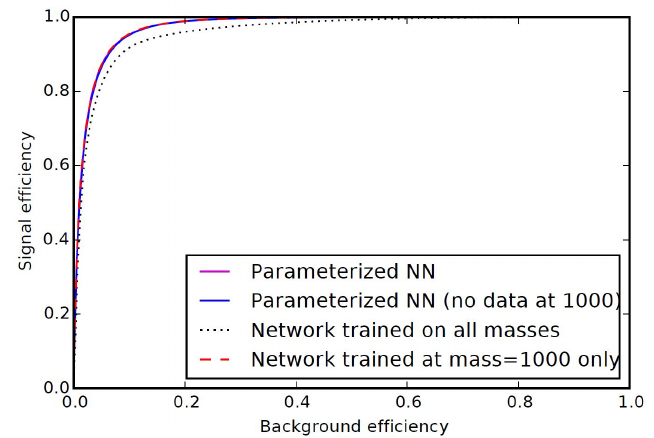
Figure 12 . Comparison of signal and background efficiency curves for four classes of neural networks on the HEPMASS dataset. Of relevance here is the dashed red curve, which correspond to a non-parametrized network trained and tested on the sample of reference, with a resonance mass of 1000 GeV. Reprinted with permission from [18].